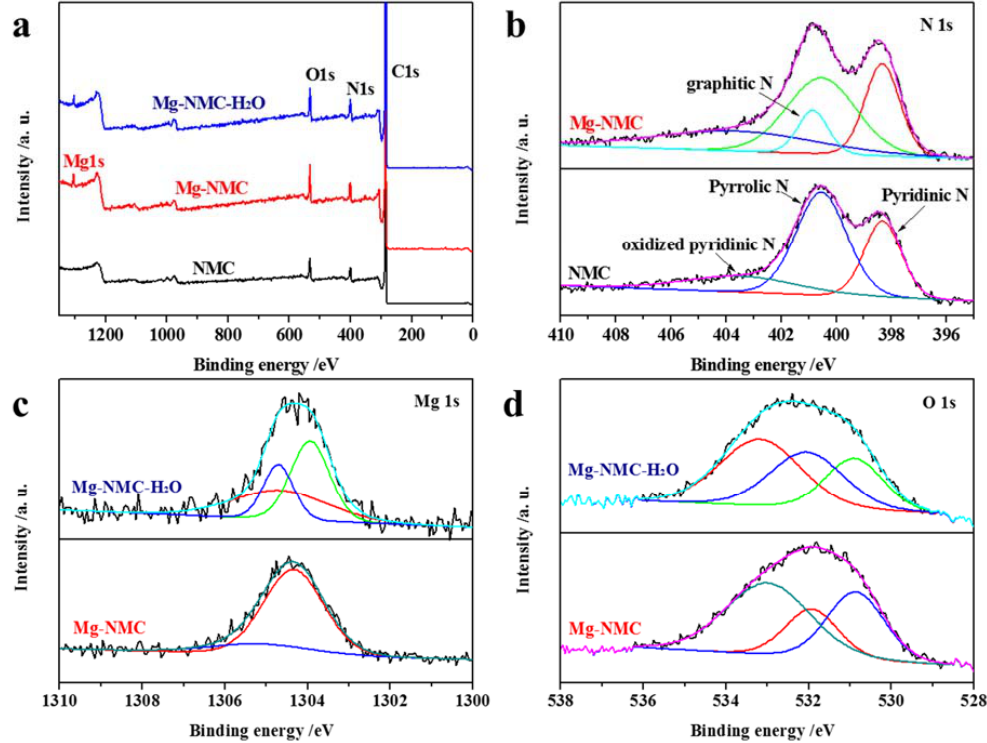
Figure 1. ( a ) XPS survey spectra for NMC, Mg-NMC and Mg-NMC-H 2 O; ( b ) XPS N 1s spectra of NMC and Mg-NMC; ( c ) XPS Mg 1s and ( d ) O 1s spectra of Mg-NMC and Mg-NMC-H 2 O.